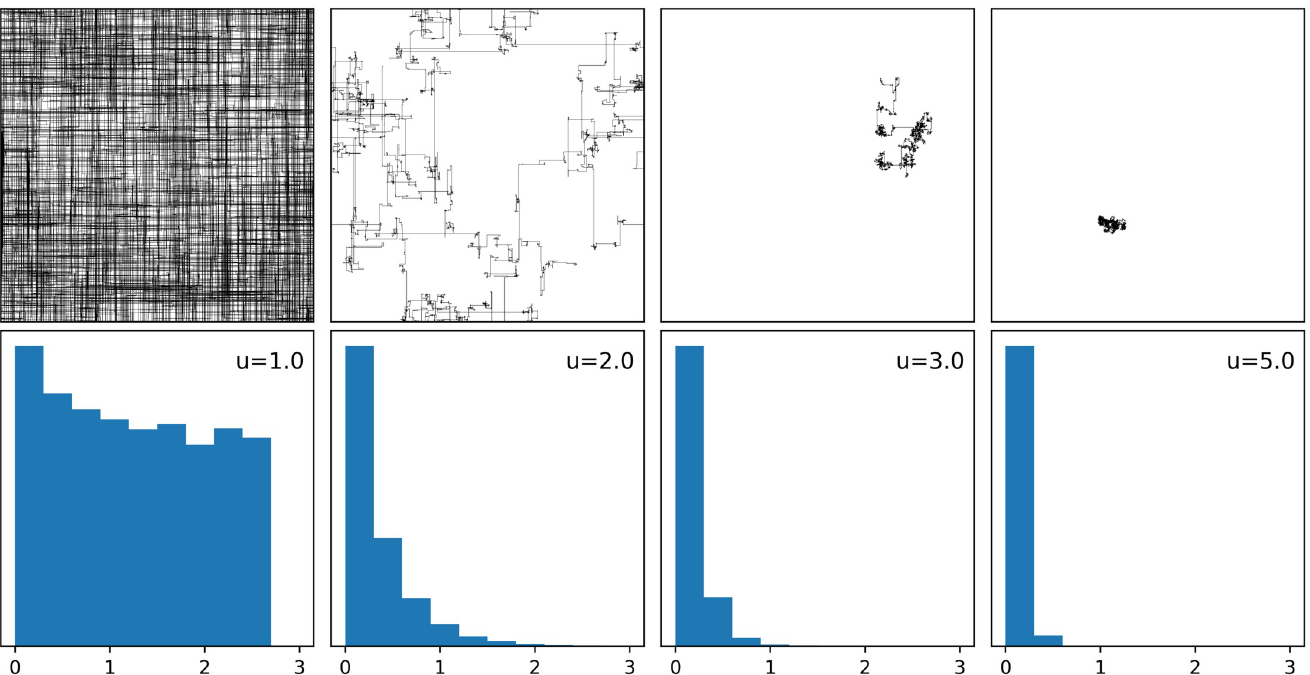
Fig 1. Examples of random walks. Four random walks (top) of 10 4 segments with move lengths pulled from a discrete truncated power-law distribution with exponents u = 1.0, 2.0, 3.0 and 5.0, with random direction from {0, π /2, π , 3 π /2}. The walks begin at a random location on a 1000 × 1000 toroidal environment and their power-law distribution (bottom) is shown as a histogram of 10 4 logged move lengths truncated to half the length of the environment. Walks with exponents near u = 1.0 exhibit ballistic movement, diffusive movement near u = 2.0, and superdiffusion for u �